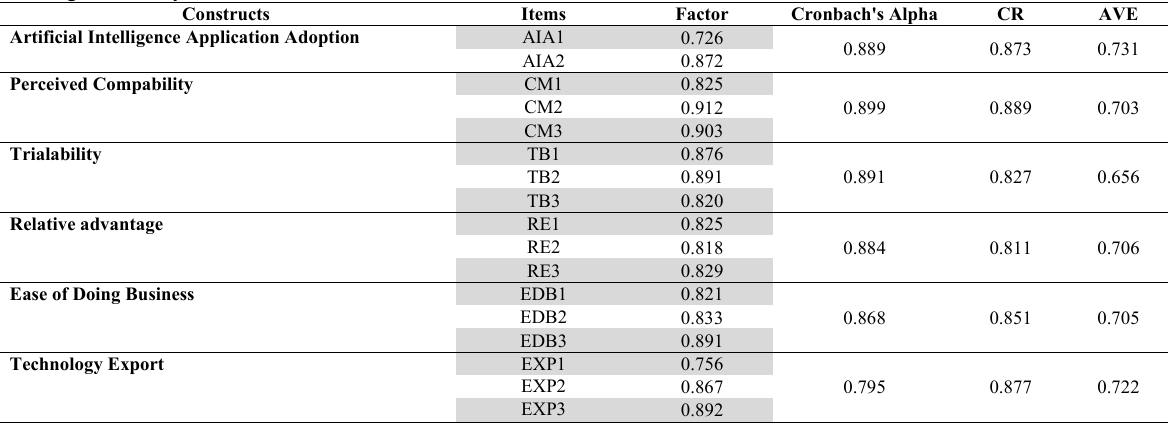
Convergent validity